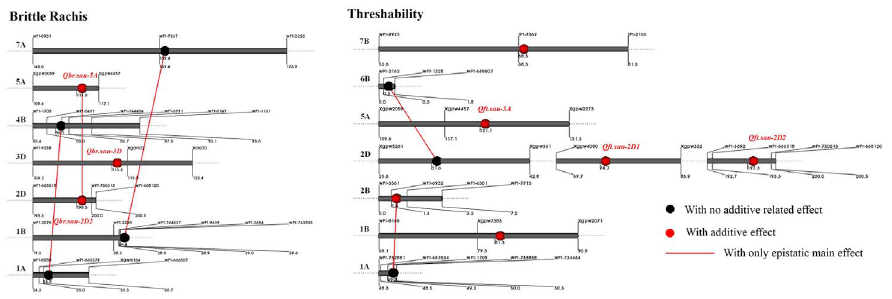
Figure 7. Location of additive and epistatic quantitative trait loci (QTLs) for brittle rachis and threshability on linkage groups in joint analysis of the two-year data. The chromosome names are listed on the left of the bar , the map distances (cM) are shown below the bar , and the markers are shown above the bar . The major additive loci are annotated in red color.